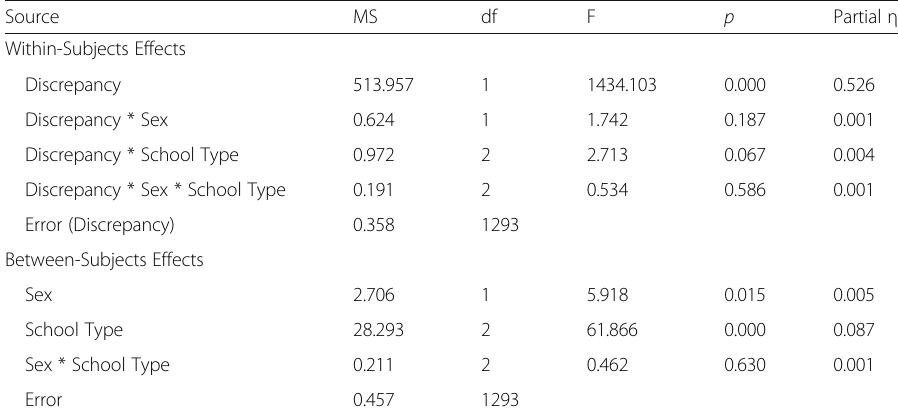
Table 5 Repeated measures ANOVA results for constructivist teaching ( N = 1299) Source